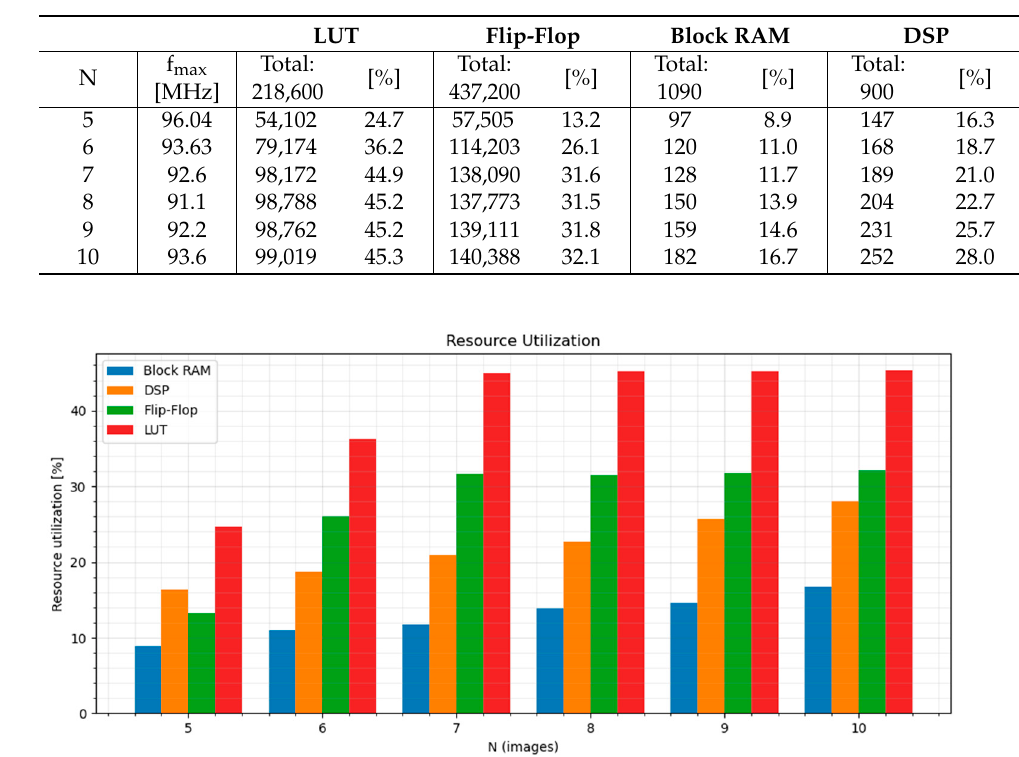
Figure 9. Resource utilization of individual FPGA primitives for the proposed design. Table 2. Utilization report of the implemented design at N = 10. * The AXI Interconnect component is a Xilinx IP block. The processing system (ARM Cortex PS) is implemented in silicon but requires some logic utilization for